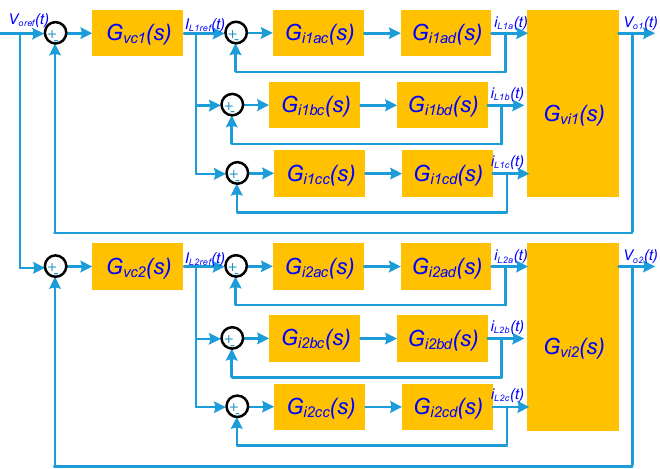
Figure 8. Control diagram of the implemented controller.